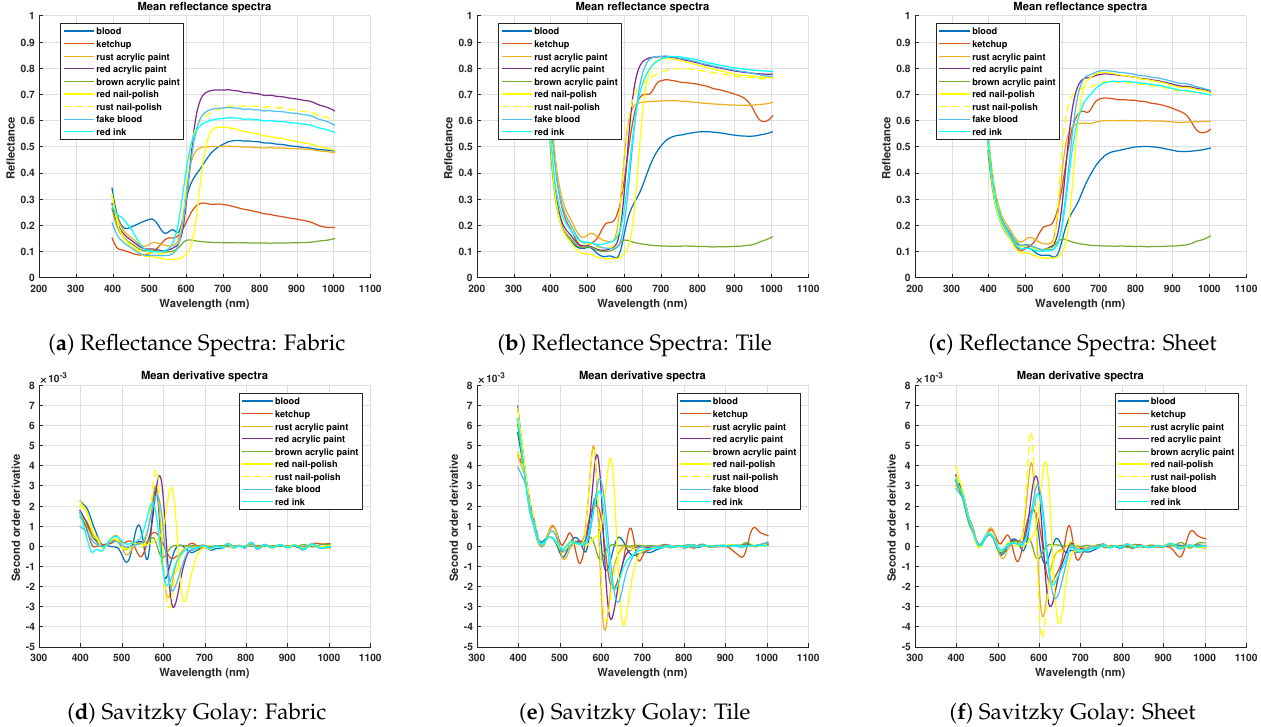
Figure 6. Mean reflectance spectra and Savitzky Golay second order derivative spectra of blood and non-blood samples comparison on white fabric, white tile, and wall